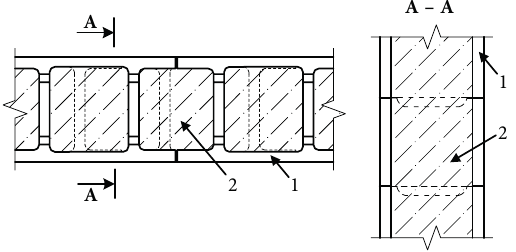
A – A A 12 A Fig. 1. Masonry unit with concrete filled hollowness masonry solution: 1 – hollow masonry unit; 2 – infill concrete